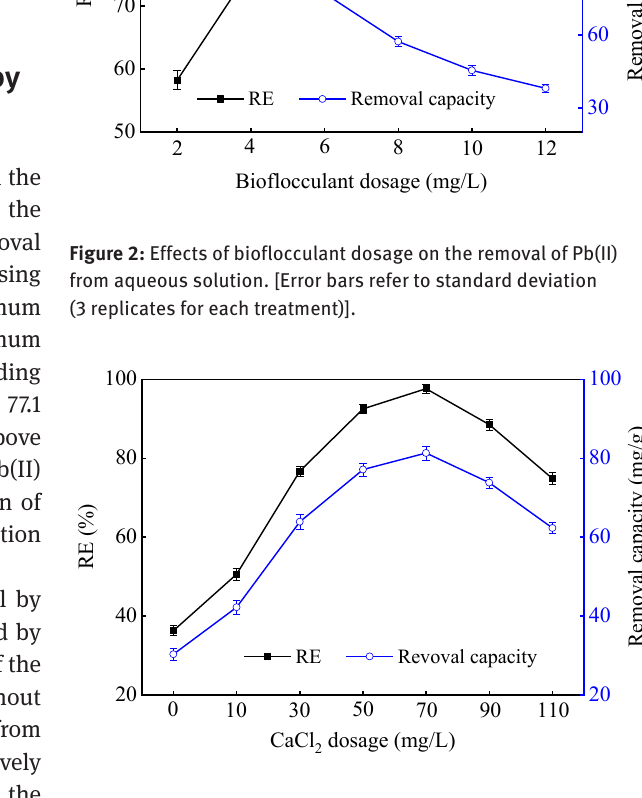
Figure 3: Effects of CaCl2 dosage on the removal of Pb(II) from aqueous solution. [Error bars refer to standard deviation (3 replicates for each treatment)].